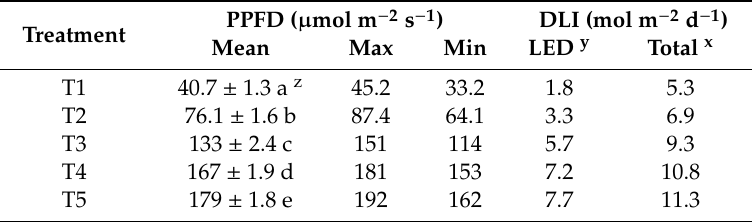
Table 1. Canopy-level supplemental photosynthetic photon flux density (PPFD) of the five supplemental light-emitting diode (LED) treatments and their associated supplemental and total daily light integrals (DLI). Treatment